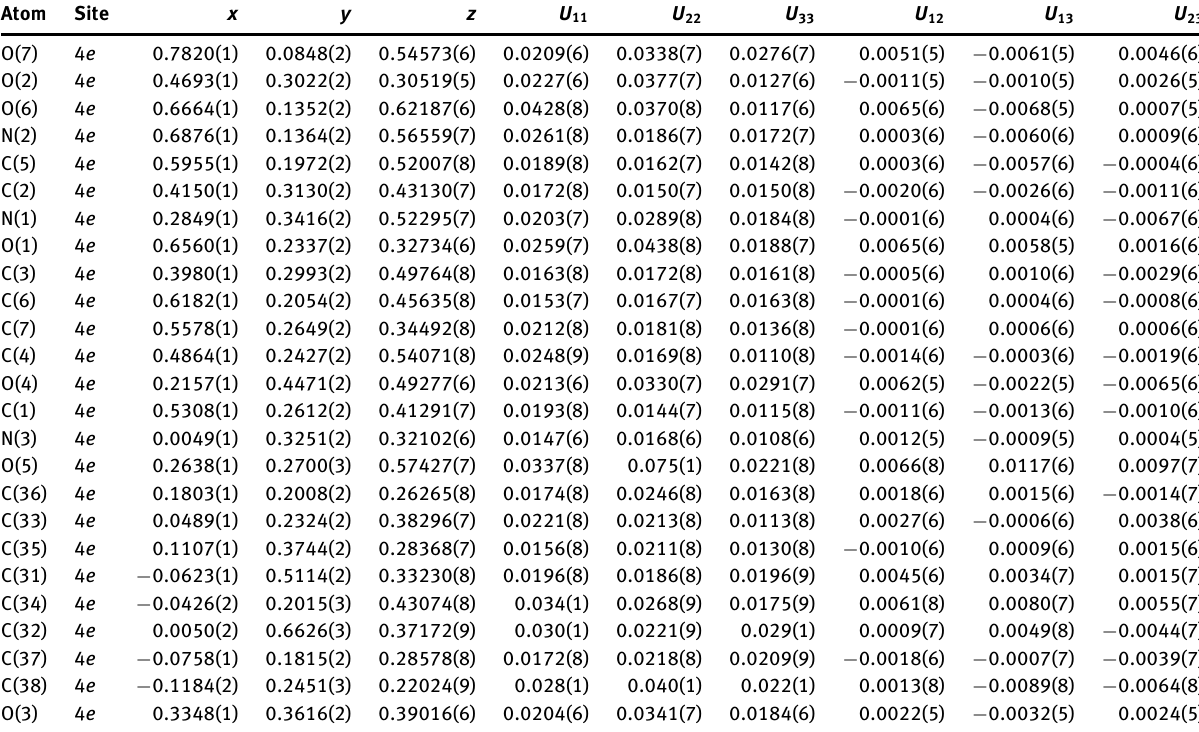
Table 3: Atomic displacement parameters (Å 2